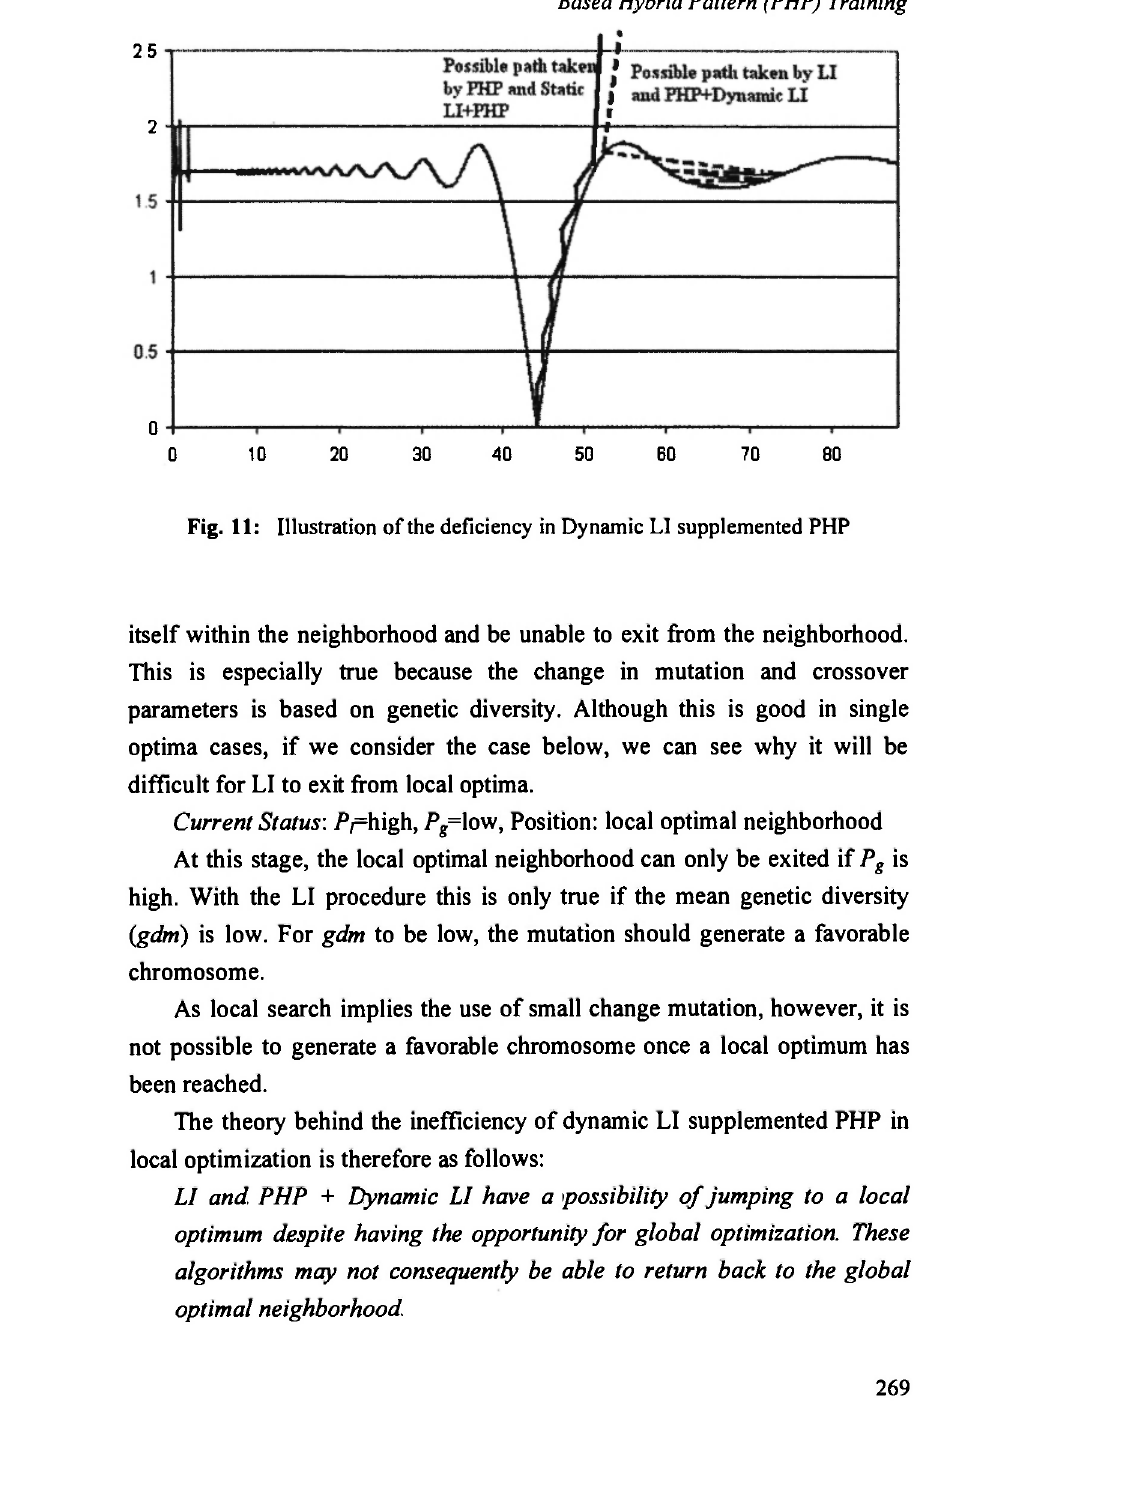
Fig. 11: Illustration of the deficiency in Dynamic LI supplemented PHP